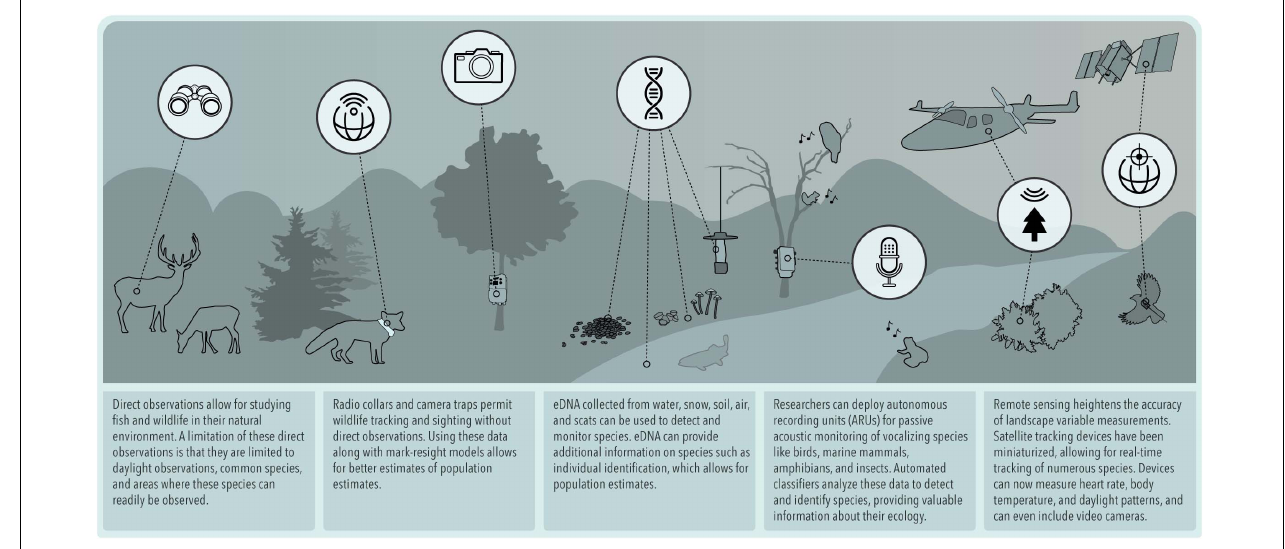
FIGURE 1 | Technology-fueled innovation that is allowing for next-generation natural history.